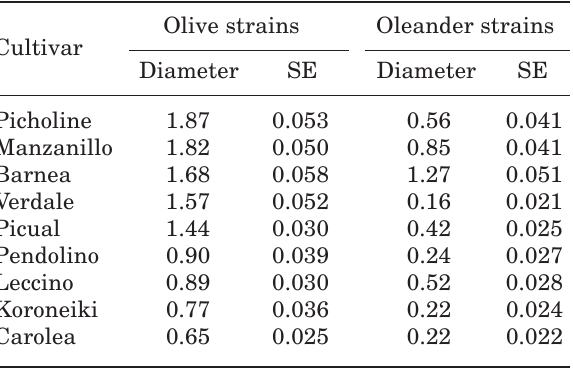
Table 2. Combined gall diameters (mm) in nine olive cultivars inoculated with P. savastanoi olive knot strains ICMP 13519 and 13813 and P. savastanoi oleander knot strains ICMP 791 and 13815 at concentrations of 3 (cid:1) 10 6 cfu ml -1 , recorded after 2 months. Mean diameters with their standard errors are indicated.